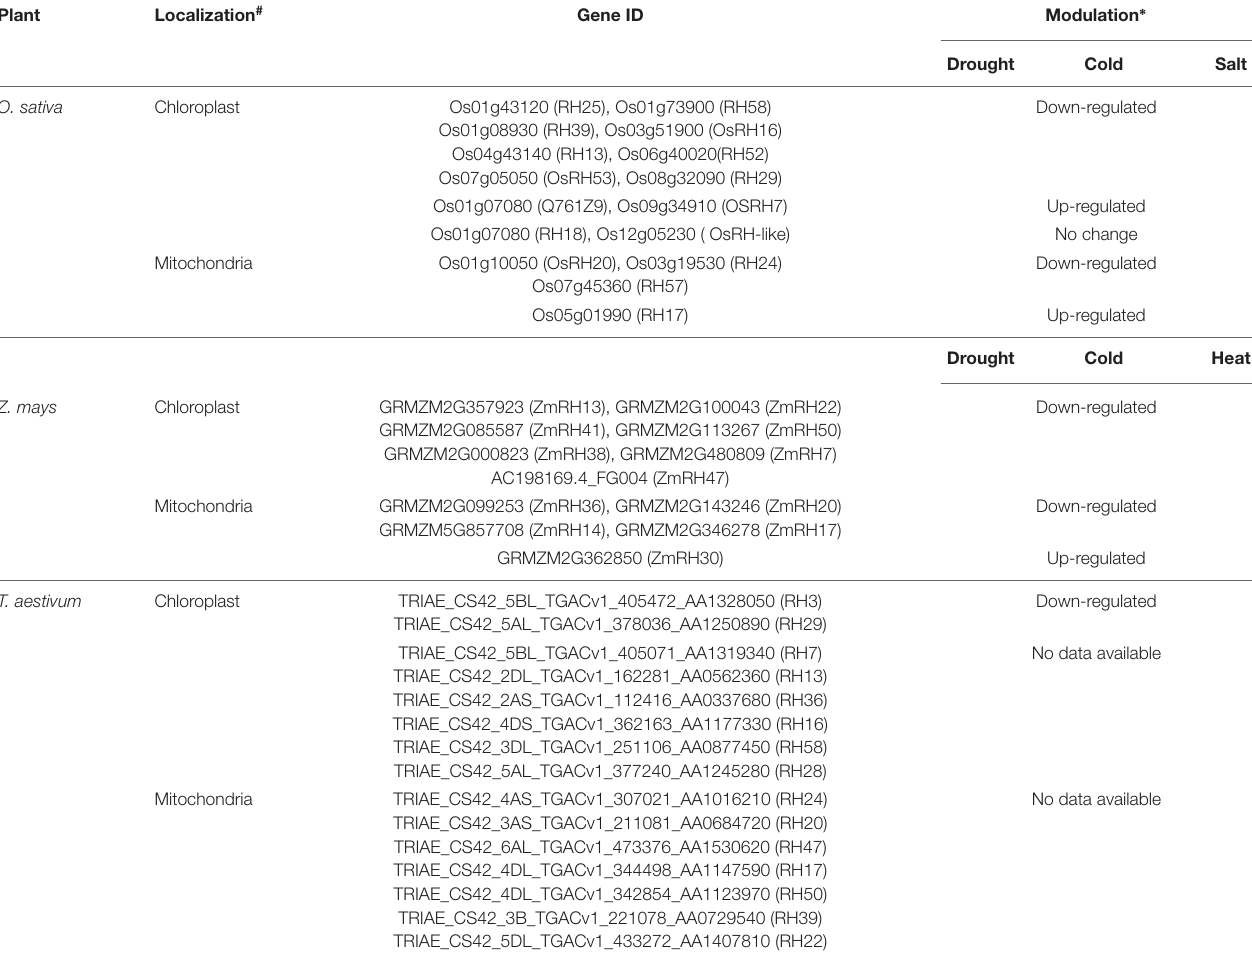
TABLE 2 | List of predicted chloroplast- or mitochondria-targeted DEAD-box RHs and stress-responsive expression patterns. Plant Localization